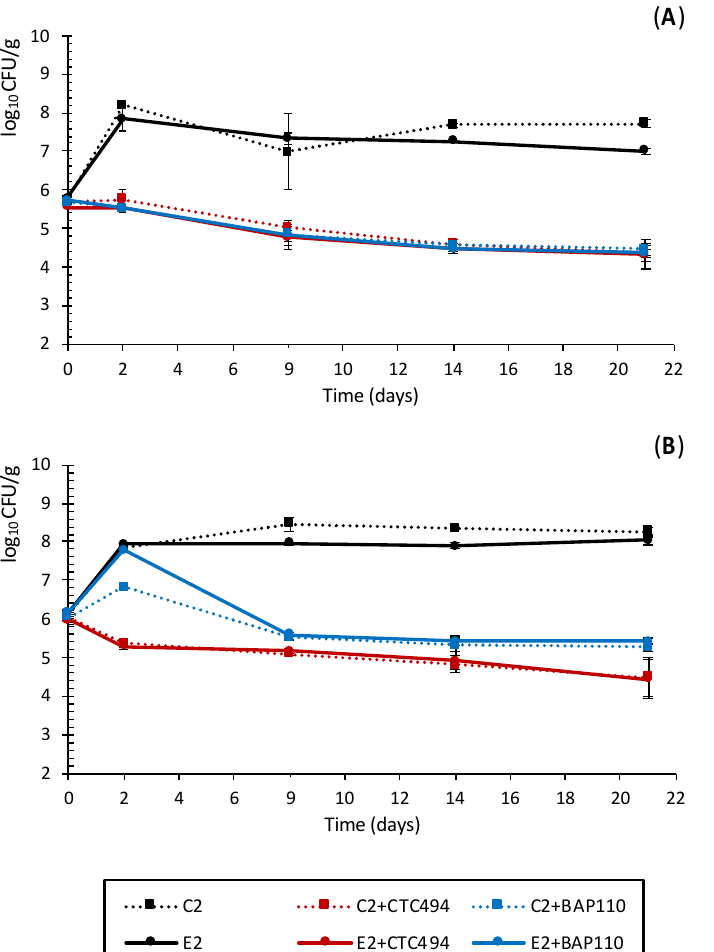
Figure 4. Behavior of Salmonella ( A ) and Listeria monocytogenes ( B ) strains in sausages spontaneously fermented with (E2) and without (C2) the addition of 0.3% of LPE or fermented with the starter culture L. sakei CTC494 or L. sakei BAP110 with (E2 + CTC949 or E2 + BAP110) or without (C2 + CTC494 or C2 + BAP110) the LPE.